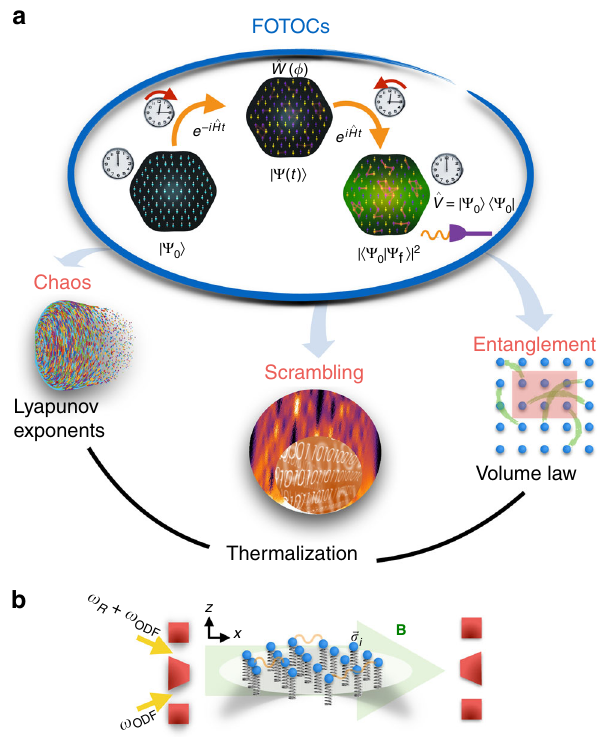
Fig. 1 Unifying chaos, scrambling, entanglement and thermalization through the measurement of fi delity out-of-time-order correlators (FOTOCs). a Scheme: an initial state, | ψ 0 〉 is evolved under an interacting Hamiltonian ^ H for a time t . Inverting the sign of ^ H and evolving again for time t to the fi nal state | ψ 〉 , implements the many-body time-reversal, which ideally f takes the system back to the initial state | ψ 0 〉 . If a perturbation ^ W ð ϕ Þ is inserted between the two halves of the time evolution and the many-body overlap with the initial state is measured at the end of the protocol, ^ V ¼